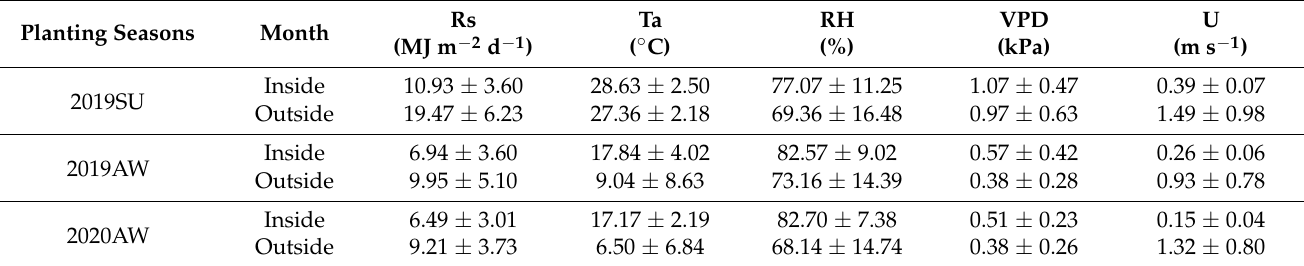
Table 2. Microclimate parameters inside and outside the sunken solar greenhouse in each tomato growth